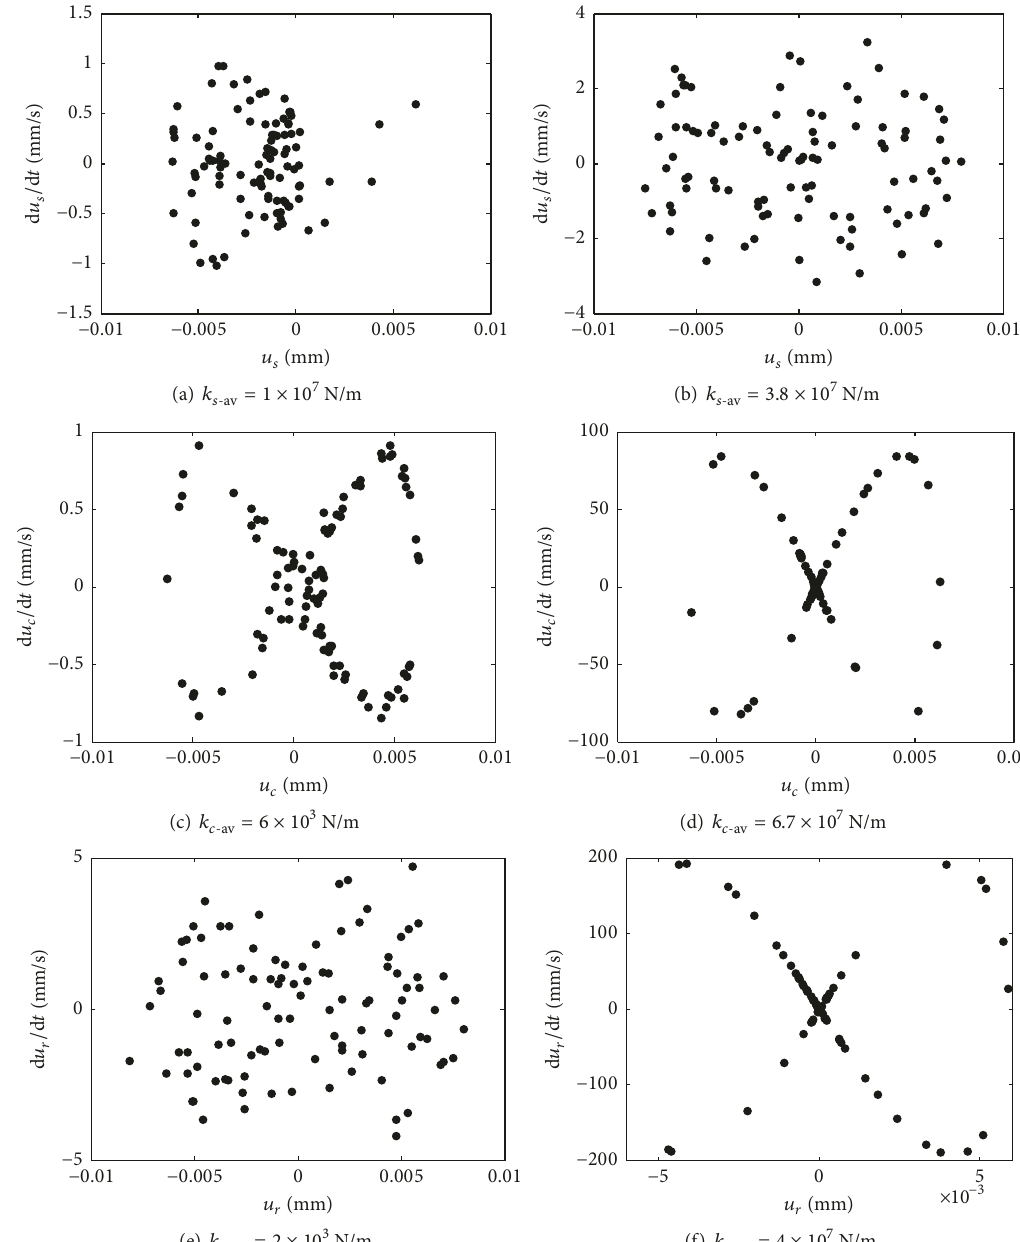
Figure 6: Poincare map of torsional vibration response for different average mesh